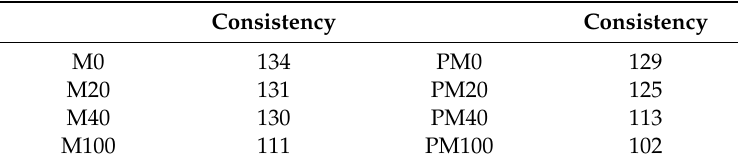
Table 4. Consistency values of mortar families (mm).